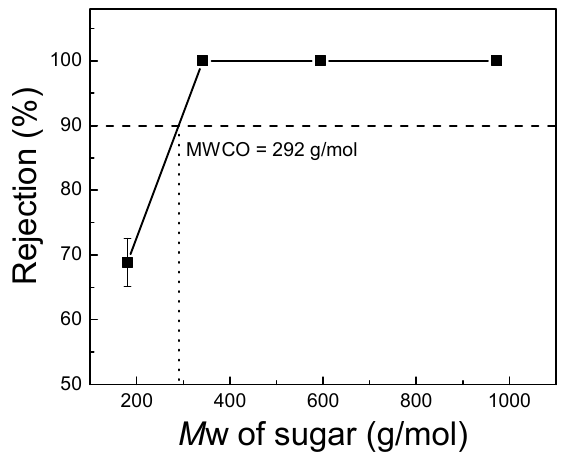
Figure 9. Determination of the molecular weight cutoff of TFC–PEG20k. Feed = 1000 ppm aqueous sugar solution. Operating conditions = 0.60 MPa and 25 °C.